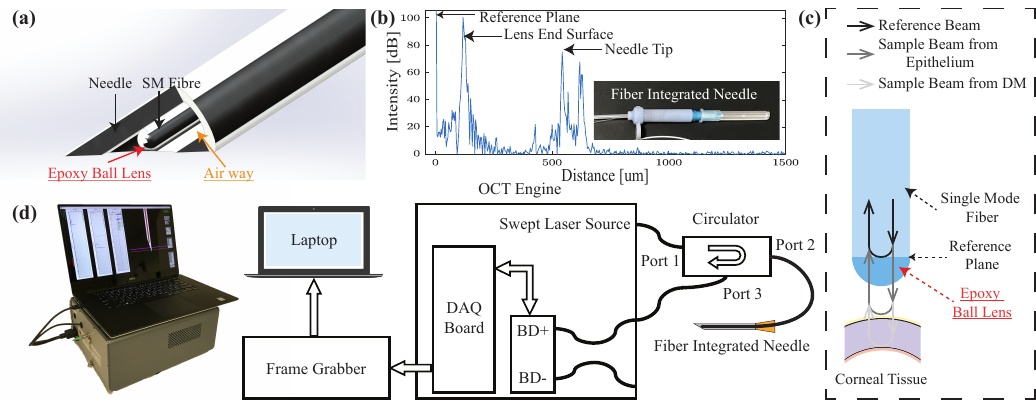
Figure 2. ( a ) Schematic of the distal sensor integrated needle ( b ) A-scan image of the needle tip, lens surface, and reference plane. ( c ) Schematic of the proposed ball lensed fiber probe (For simplicity, only show the sample beam from epithelium and DM). ( d ) System diagram of the common-path swept source optical coherence tomography (OCT) system (BD: balanced